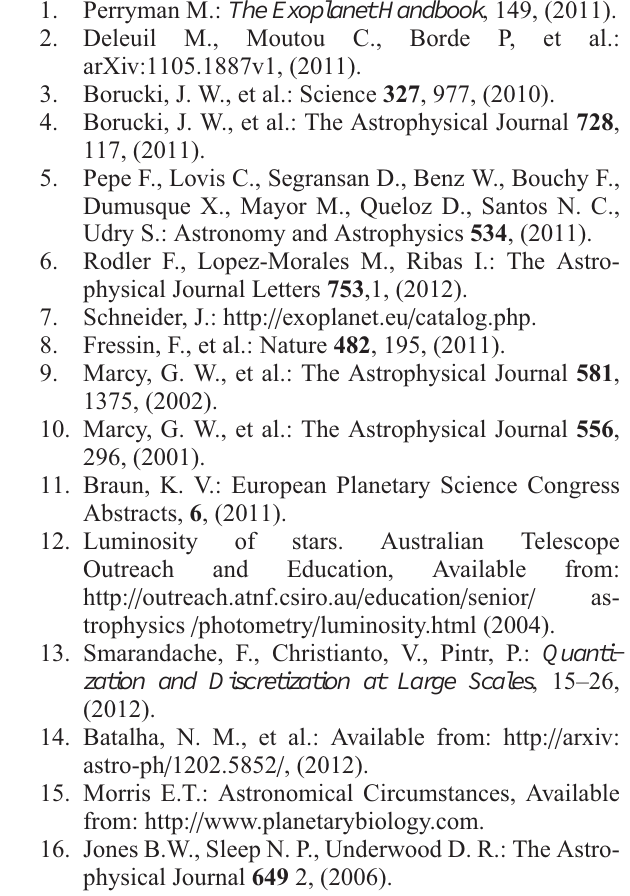
Fig. 6. Dependence of the parameter r p T e ff on r p v p for di ff erent stellar spectral